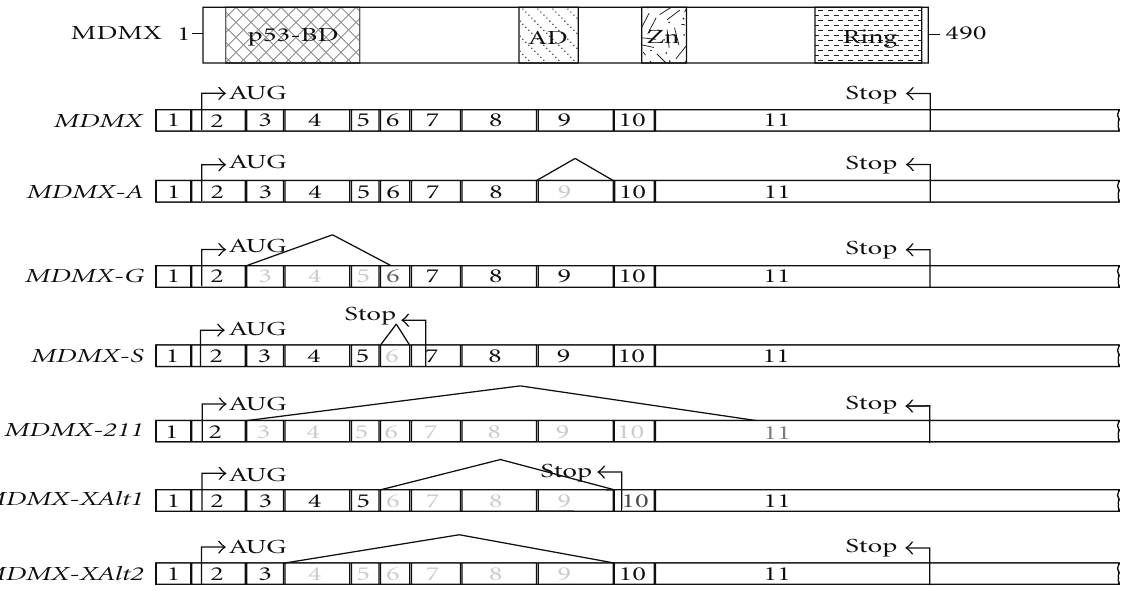
Figure 2: Schematic representation of the MDMX protein, the mdmx mRNA and the reported mdmx splicing